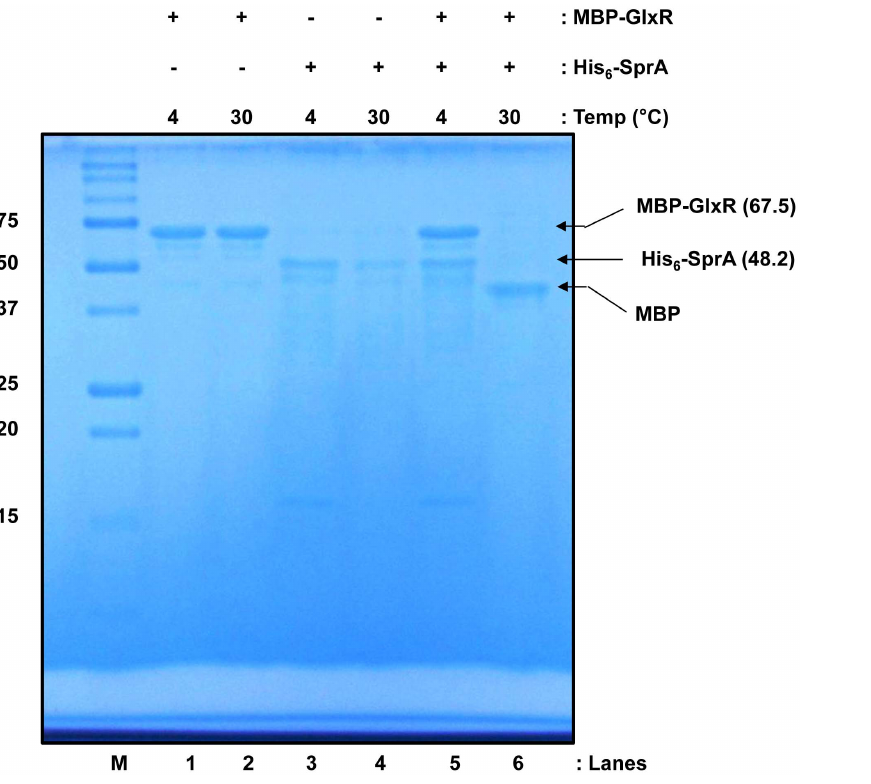
Figure 5. Invitro digestion of MBP-GlxR by His 6 -SprA. Protein purification and proteolytic assays were performed as described in the Materials and Methods. Proteins were incubated at 4 u C or 30 u C for 24 h, analyzed on a 15% SDS-PAGE gel, and then visualized by staining with Coomassie brilliant blue G250. Molecular weights are shown in kDa. MBP, maltose-binding protein; M, molecular weight markers; and OD, optical density.